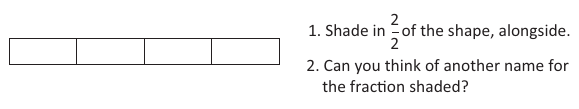
FIGURE 1: Different fractions that name the same whole ( Adapted from the Trends in Mathematics and Science Study